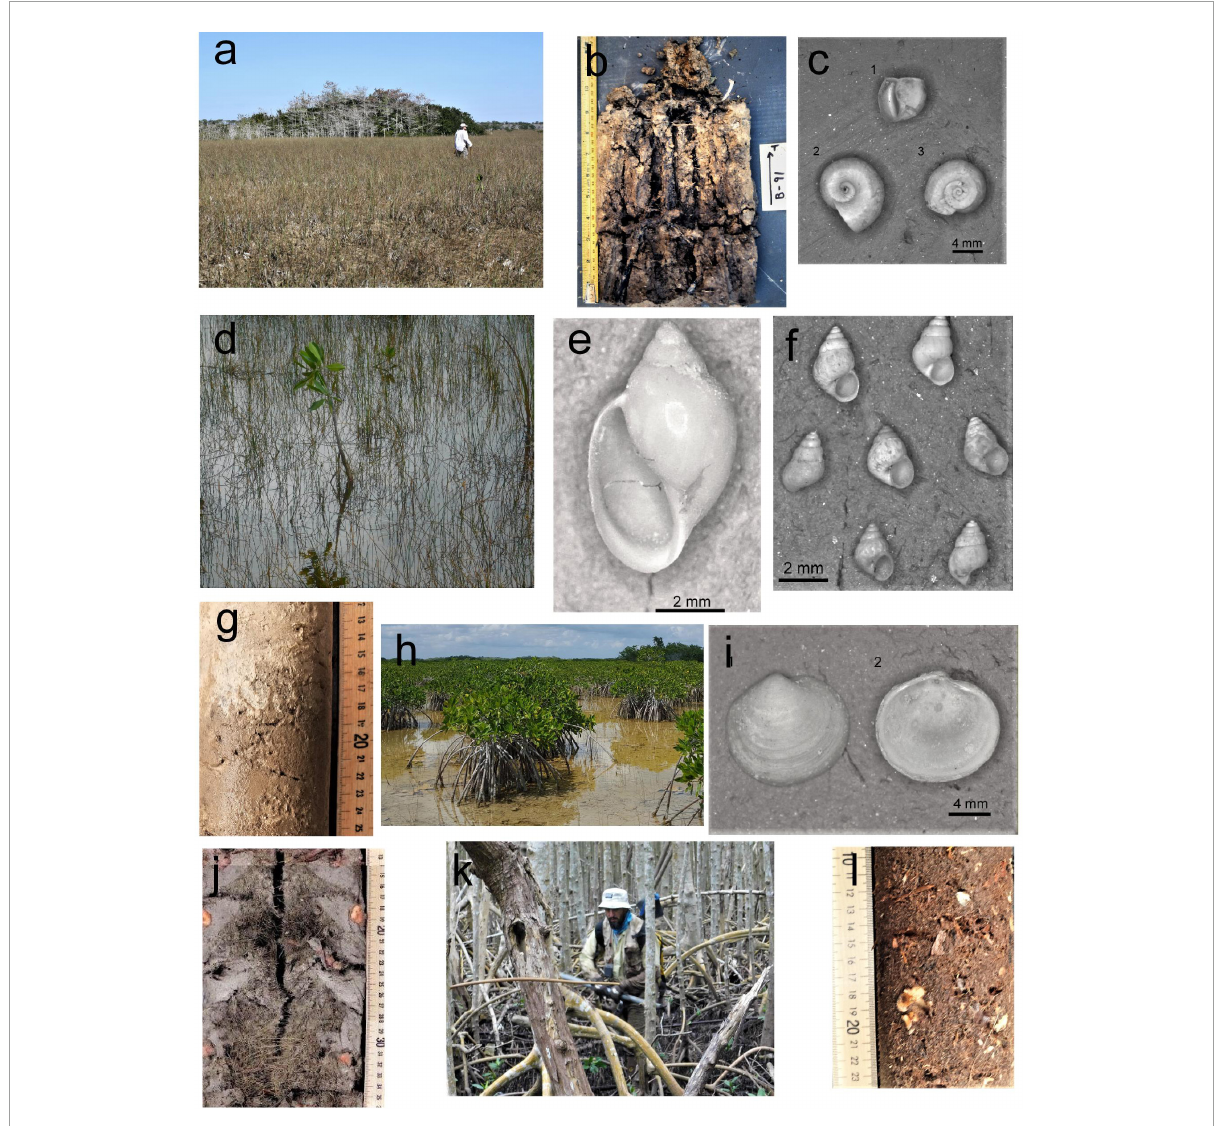
FIGURE2 Plant community and associated biogenic sediment with characteristic mollusk. (a) Saw grass community, (b) Saw grass peat marl overlain by white marl (TKYINT, l7–32 cm), (c) immature Planorbella scalaris, typical freshwater gastropod (upper shell 2.2 mm in width), (d) Eleocharis- penphyton prairie, (e) white mail overlying tan marl (Core TKYW: I2–25 cm), (f) the euryhaline Hydrobiid, Littoridinops monoroensis (average 2 mm in height), the most abundant algal grazing gastropod, (g) freshwater Physa cubensis, a detritivore gastropod, (h) mangrove scrub, (i) mangrove peat marl (Core X: 17–35 cm), (j) immature filter feeding marsh clam, Cyrenoida floridana (5.5 mm in height), (k) mangrove fringe, and (l) mangrove peat (Core X : 9–25